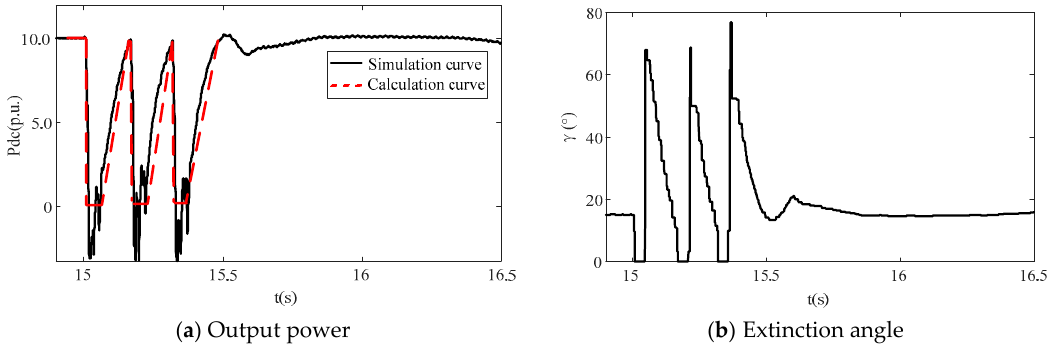
Figure 6. Operation characteristic of DC 1 under continuous CFs.